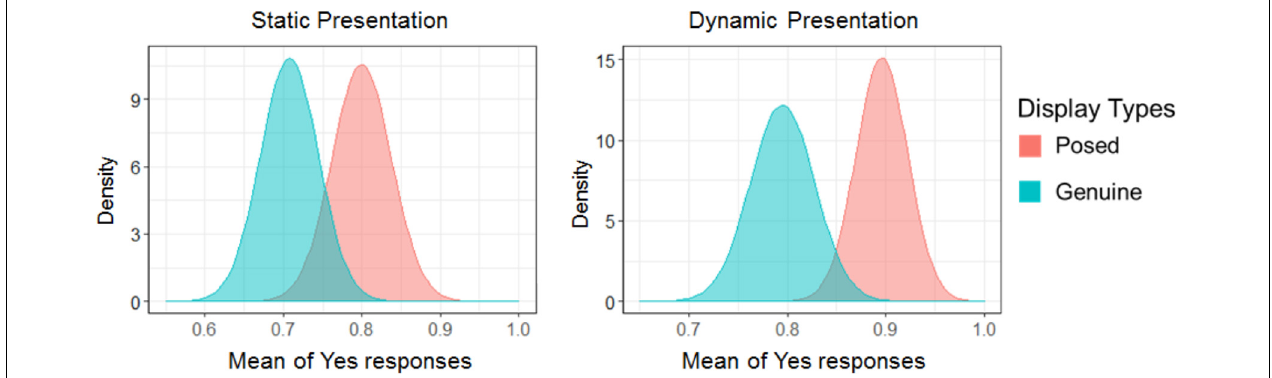
FIGURE 2 | The mean of Yes responses in the show condition for all emotions. The distance between the two distributions can be interpreted as the discriminability of facial displays.